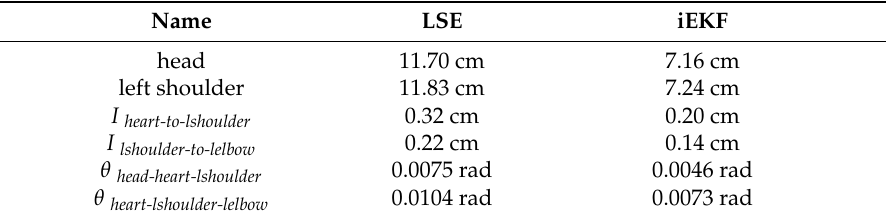
Table 4. Mean deviation comparison in tag position, vector norm and posture angle.